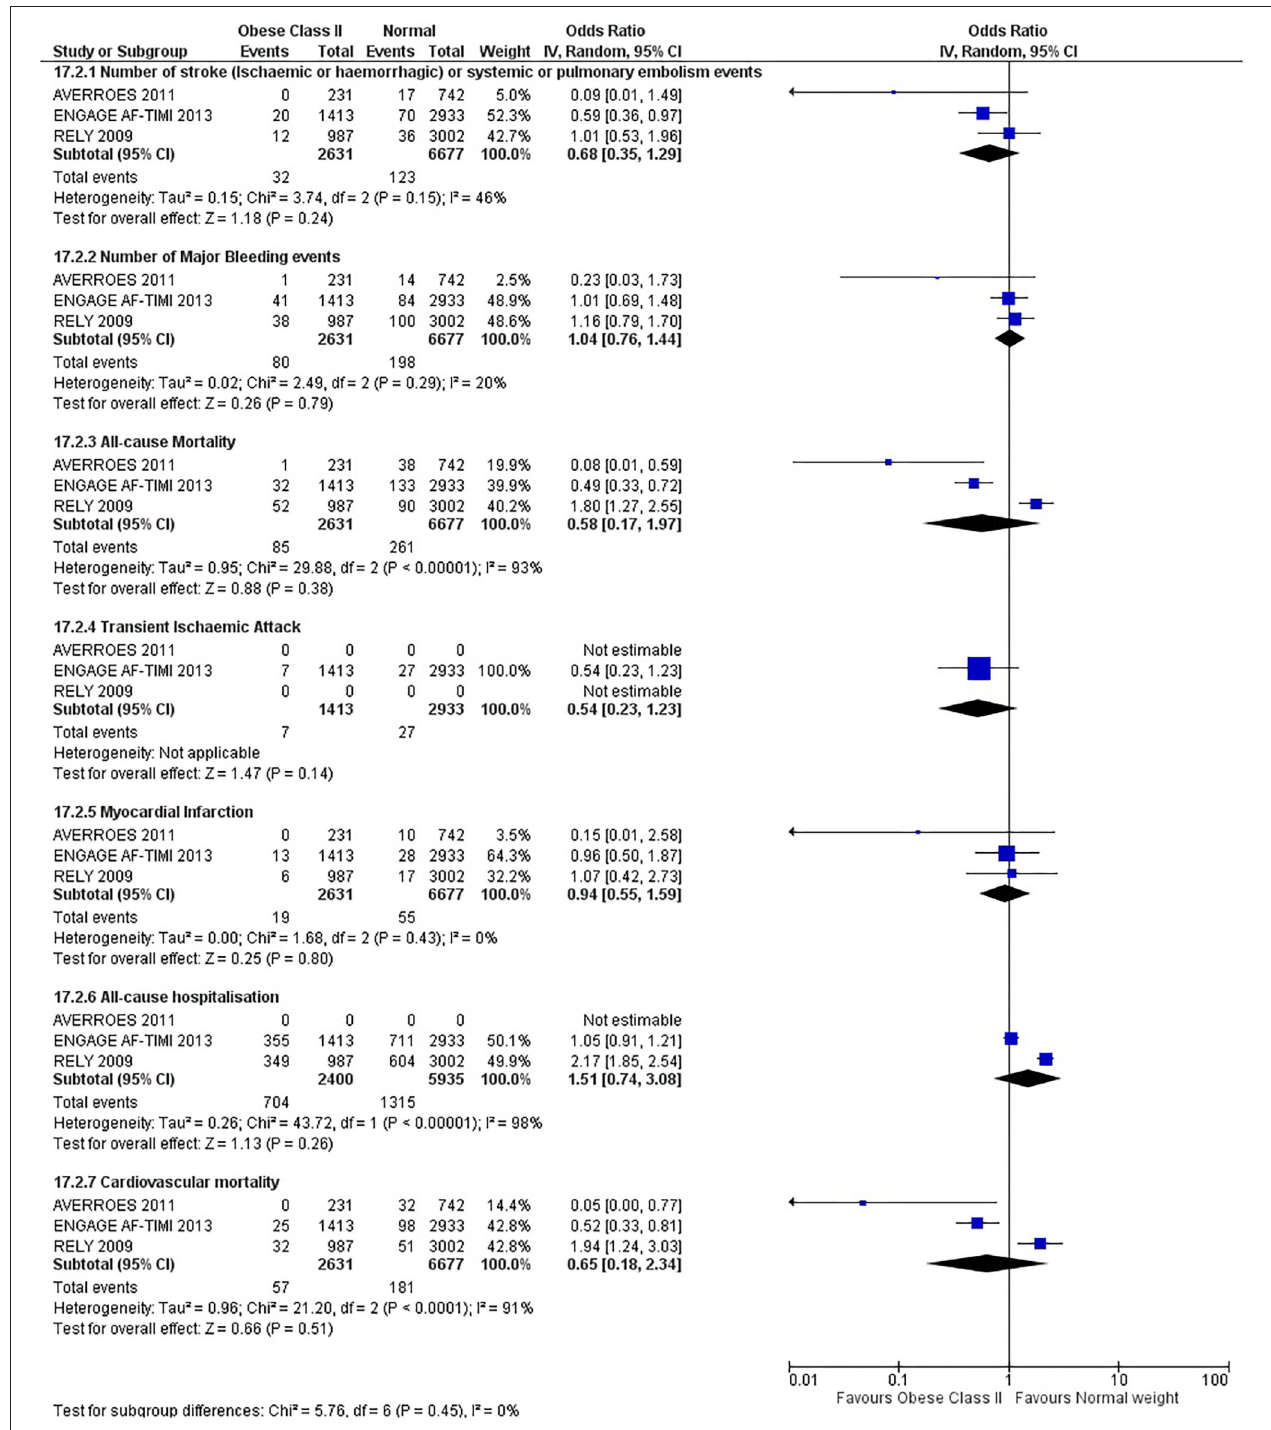
FIGURE 6 | Forest plot of comparison: Normal vs. Obese class II at 12 months.